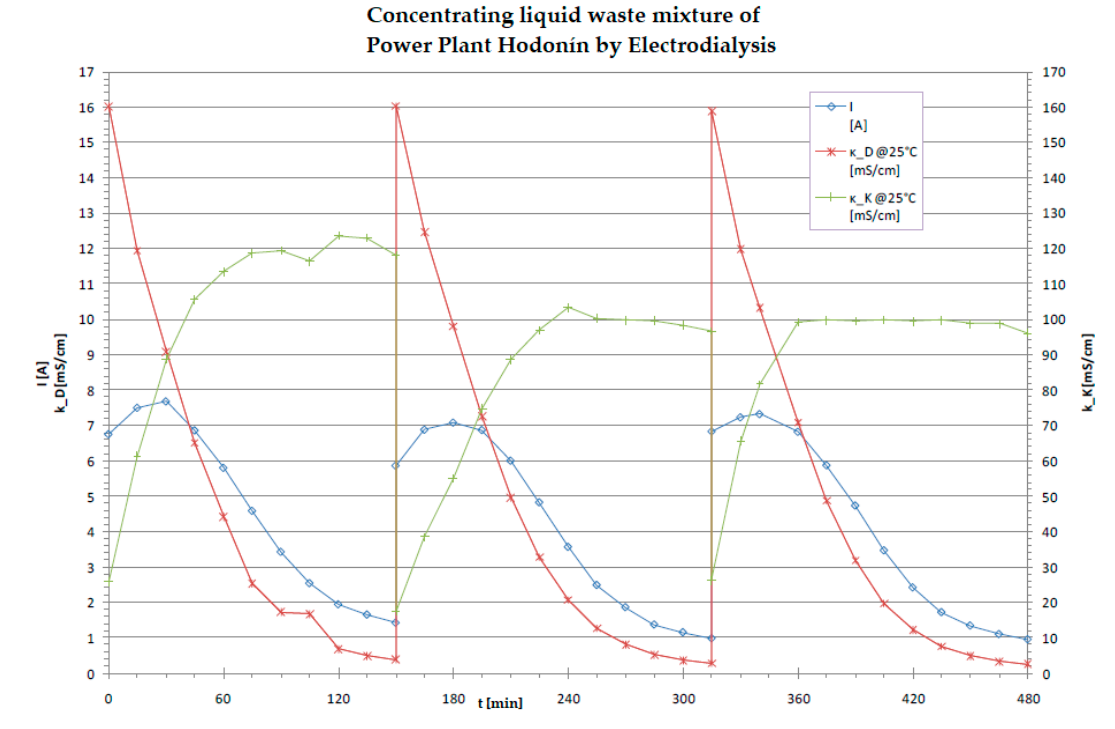
Figure 10. The concentrating of cooling tower blowdown (approx. 16 mS.cm − 1 ) mixed with all power plant waste-waters (final conductivity of dilutate k_D 1.2 mS.cm − 1 ). This waste-water in the power plant Hodonín was treated in the pilot test by an EDR-Y electrodialysis unit (Mega co) in 3 cycles. The whole volume of the batches was 323 L, and the whole volume of final concentrate (made by electrodialysis) was 15 L (conductivity of concentrate k_K 100–120 ms.cm − 1 ).